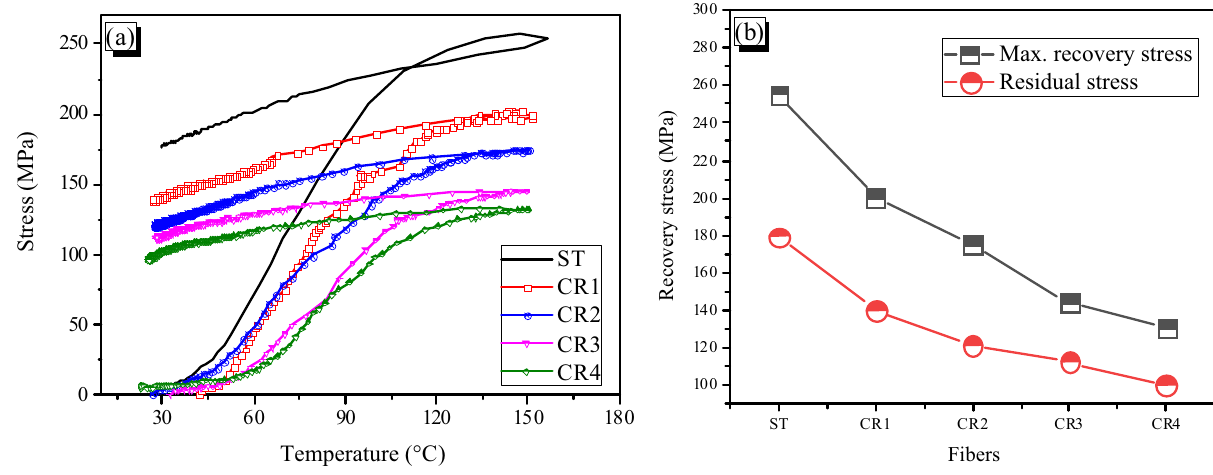
Figure 3: ( a ) Recovery stress curves at 150°C and ( b ) comparison maximal recovery stress and residual stress of ST and CR fi